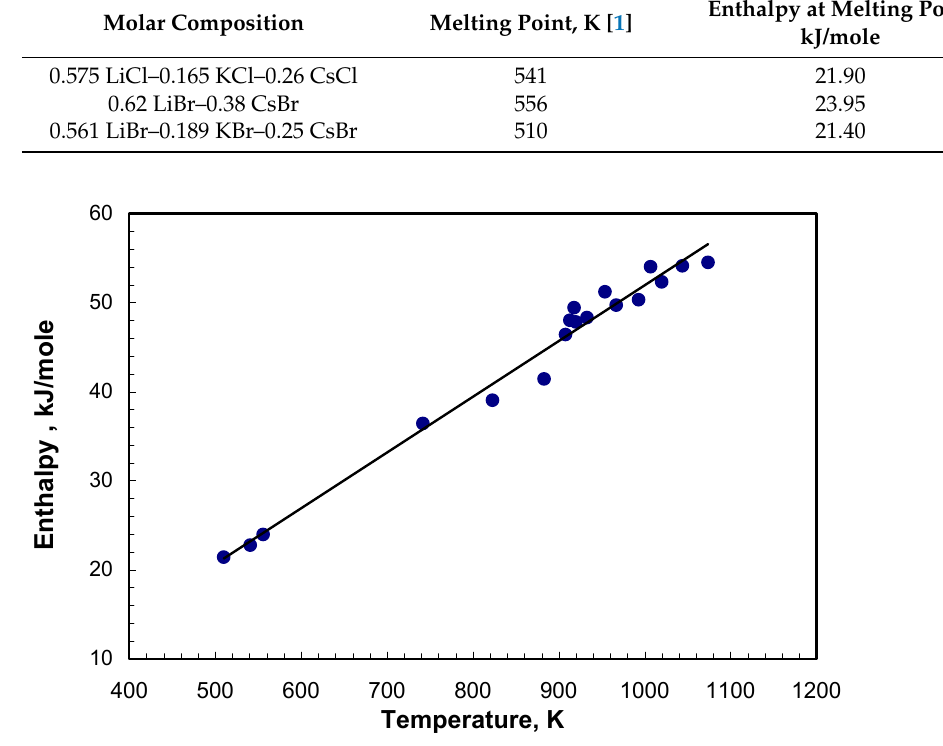
Table 4. Enthalpy ( H ) of solid halide salts before melting point ( T m ) [17]. Salt